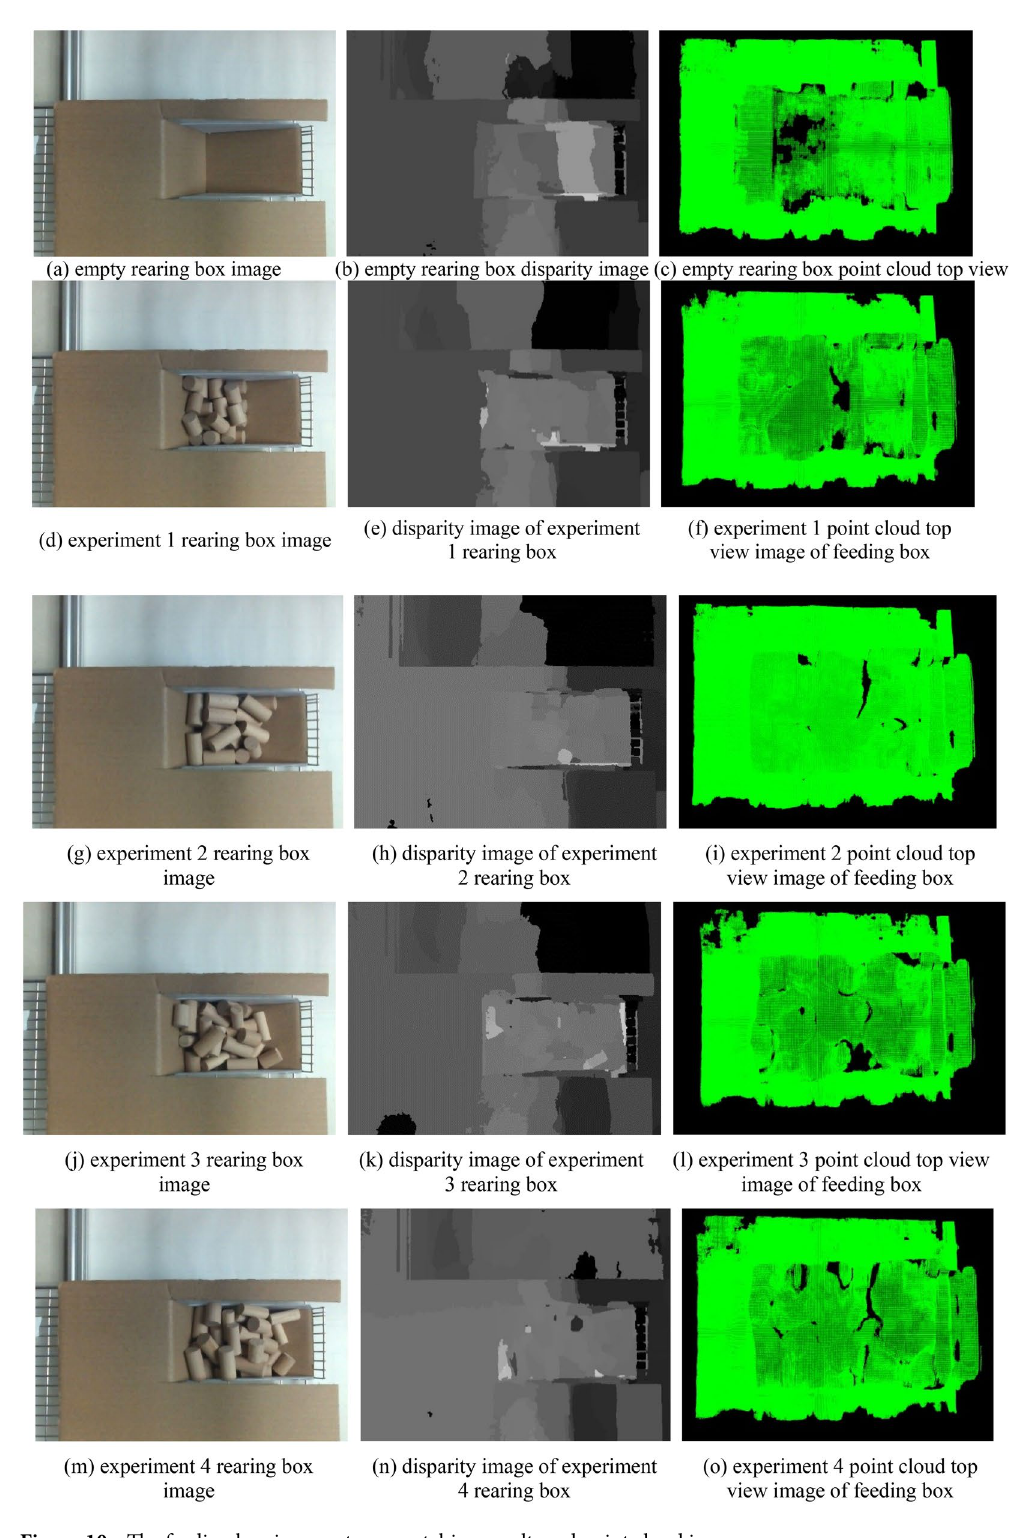
Figure 10. The feeding box image, stereo matching result, and point cloud